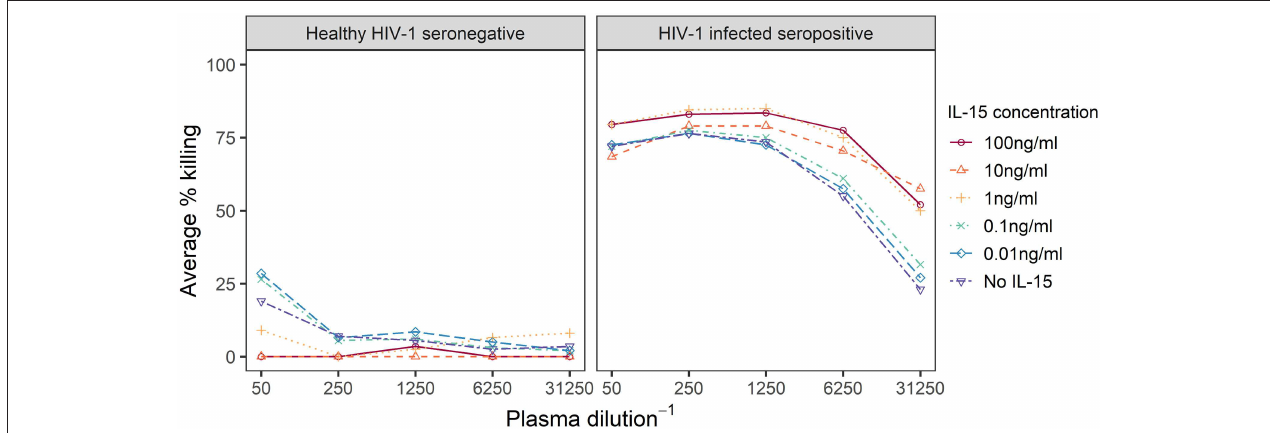
FIGURE 1 | Dilution curves representing observed % specific killing in ADCC assays performed with effector cells treated overnight with IL-15 at the indicated concentrations and plasma from a healthy HIV-1 seronegative or a HIV-1 infected seropositive individual. IL-15 concentration levels below 1ng/ml are varying shades of blue, while higher concentrations are in oranges and reds.